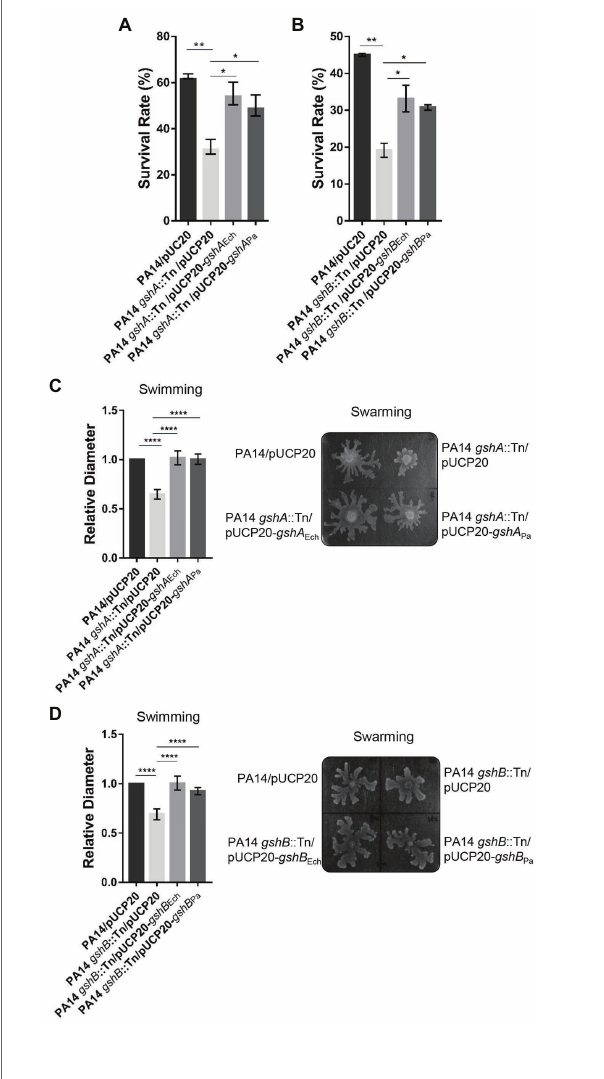
FIGURE 2 | Ehrlichia chaffeensis GshA or GshB restores the survival ability under oxidative stress and the motility of corresponding P. aeruginosa mutant. (A,B) Ehrlichia chaffeensis GshA (A) or GshB (B) confers survival ability under oxidative stress to P. aeruginosa mutant. Pseudomonas aeruginosa strains grown to an OD 600 of 1.0 were treated with H 2 O 2 at a final concentration of 50 mM at 37 ° C for 15 min. The survival rate is shown as the ratio of the colony number of each strain to that of the control group. Data indicate means ± standard deviations ( n = 3). The significant differences are represented by p -values determined with Student’s t -test (* p < 0.05, ** p < 0.01). (C,D) Ehrlichia chaffeensis GshA (C) or GshB (D) restores the swimming and swarming motilities of the corresponding P. aeruginosa mutant. Two microliters of diluted overnight culture (OD 600 = 0.1) of each strain was center spotted onto respective culture plates and incubated at 30 ° C for 16 h or at 37 ° C for 14 h, respectively. Swimming motility was assessed by measuring the diameter of the widest point of spread on each plate. Relative values to the diameter of wild-type PA14 are shown. Data indicate means ± standard deviations ( n = 5). The significant differences are represented by p -values determined with Student’s t -test (**** p < 0.0001). Swarming motility was assessed five times with similar results. Images from one typical experiment are